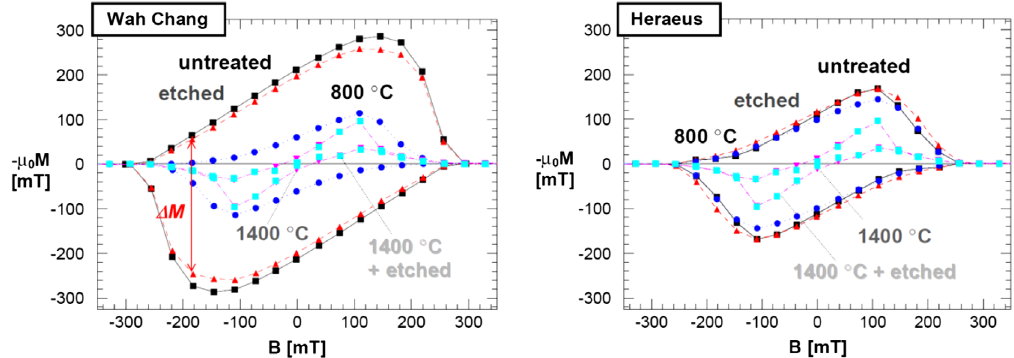
FIG. 2. dc magnetization curves from two different Nb batches (modified from [22]). At a given field, within the bean model, Δ M is proportional to the critical current J , as well to the pinning force F [26]. One can observe that recrystallization at 800 °C and even C P better at 1400 °C decreases the hysteresis in the curve, indicating a decrease in pinning efficiency. Unless the sample is a perfect ellipsoid, it is not possible to make the hysteresis totally disappear, because of surface pinning and edge